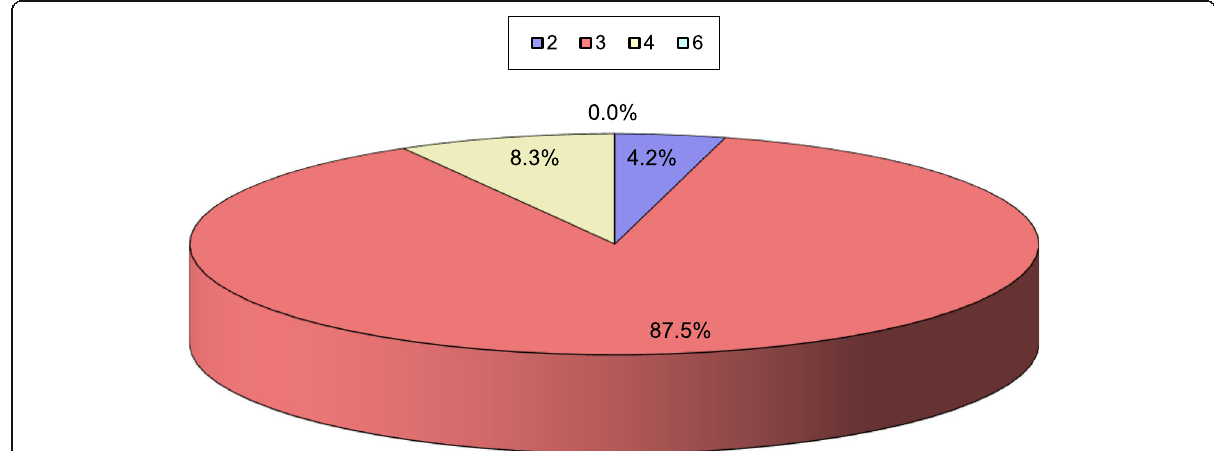
Fig. 6 The sedation scores at 45 min after midazolam administration